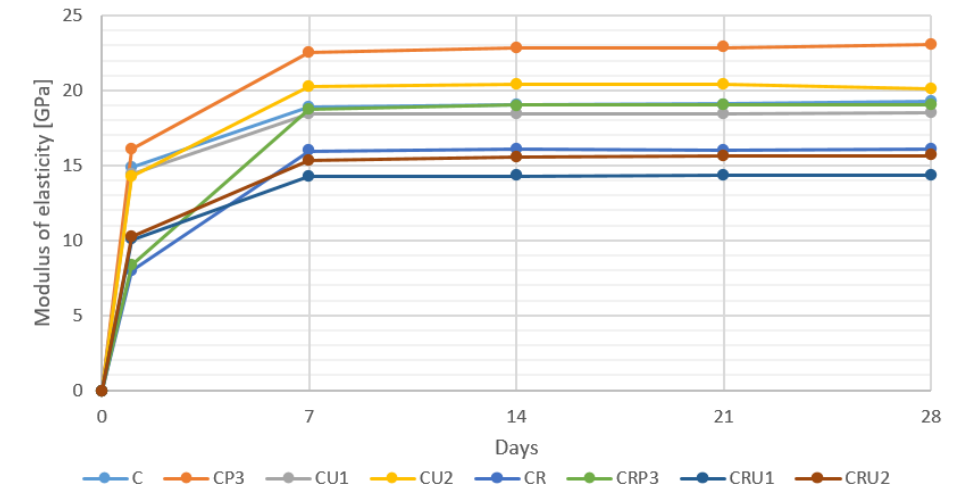
Figure 2. Increase the dynamic modulus of elasticity over time.